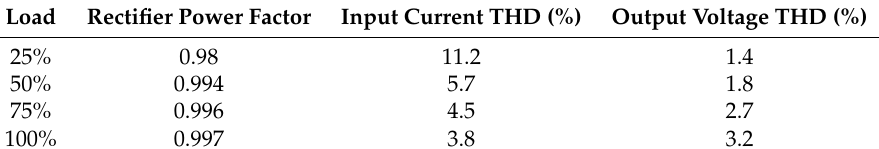
Figure 14. Measured input and output waveforms in steady state at 25% load, the input voltage is 127 V (phase-neutral). Table 8. Input and output power quality measurements under linear load condition.